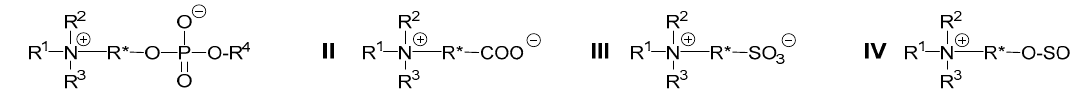
Scheme 1. Generalized structure of major polyzwitterion classes. From left to right: Ammonio